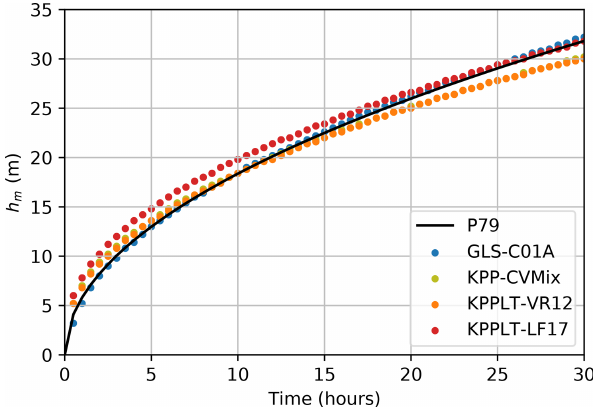
Figure 3. A comparison of the time evolution of the mixed layer depth h m in GOTM simulations defined by the depth at which N 2 reaches its maximum in color, and the prediction of Price (1979) in Eq. (2) in